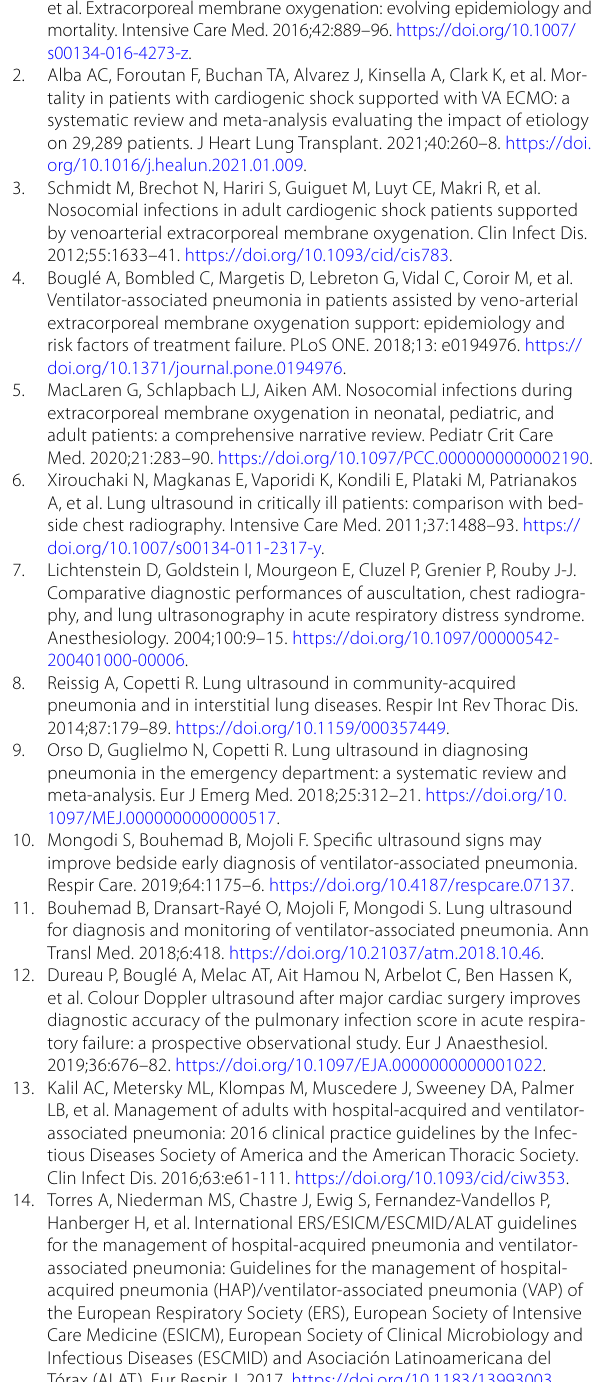
Additional file 4: Table S1. Bundle of care to prevent pneumonia in VA ECMO patients. Table S2. Lung ultrasound realization: each of